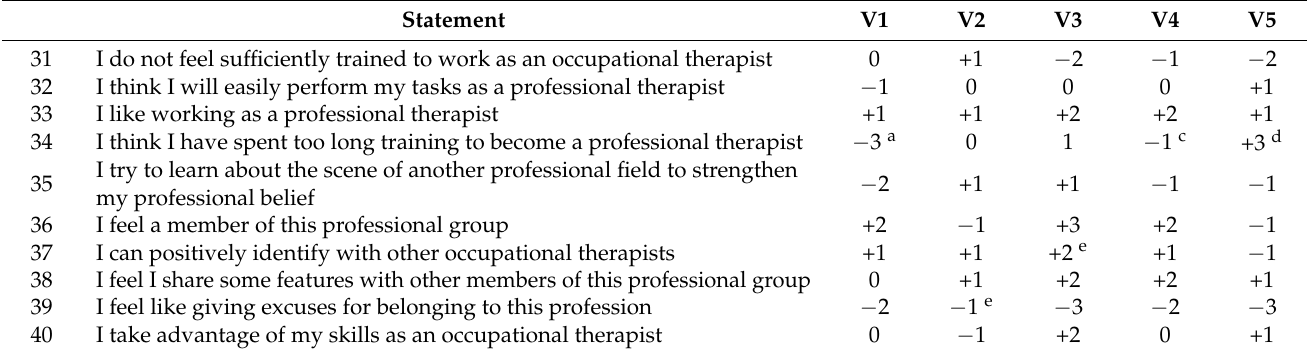
professional identity; V3: Viewpoint 3—Reaffirming a common professional identity; V4: Viewpoint 4—The role of education and mentors on the own professional identity; V5: Viewpoint 5—The outcome of ongoing training in order to develop a professional identity; The numbers ranging from − 3 to +3 correspond to location of the statements in an idealized each pattern, placed on a grid, as is shown in Figure 1. Note: a = ** ◄ ; b = * ◄ ; c: *; d = ► **; e = ► *; f: **.